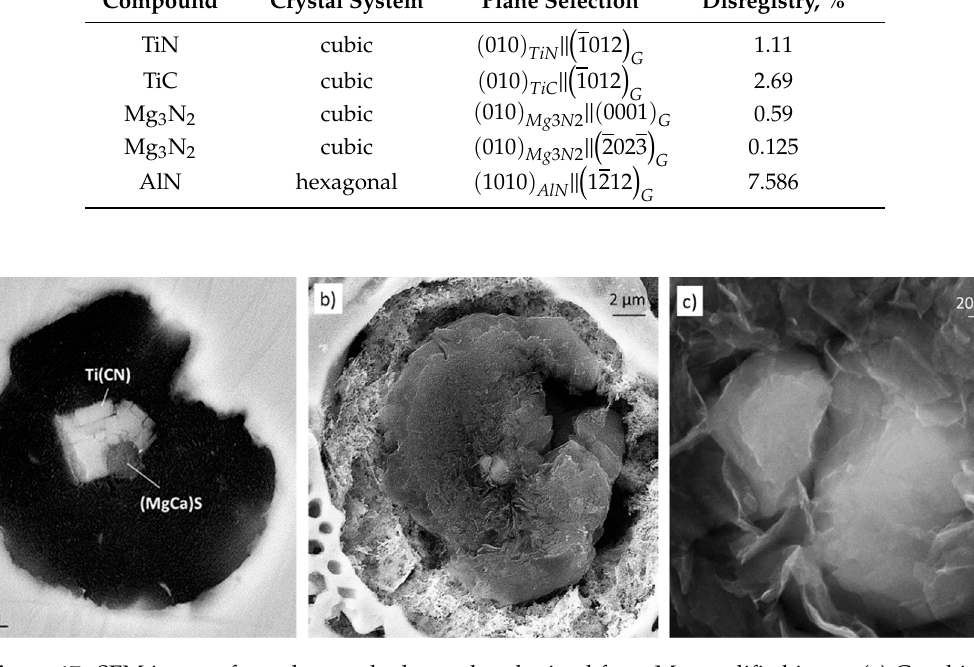
Figure 17. SEM images from deep-etched samples obtained from Mg-modified irons: ( a ) Graphite nucleating on a (MgCa)S and Ti(CN) inclusion; ( b ) spheroidal graphite growing on an Mg-Al-Si nitride nucleus; ( c ) higher magnification of ( b ) showing the nucleus made of two nitrides; reproduced from [104] with permission from Springer.